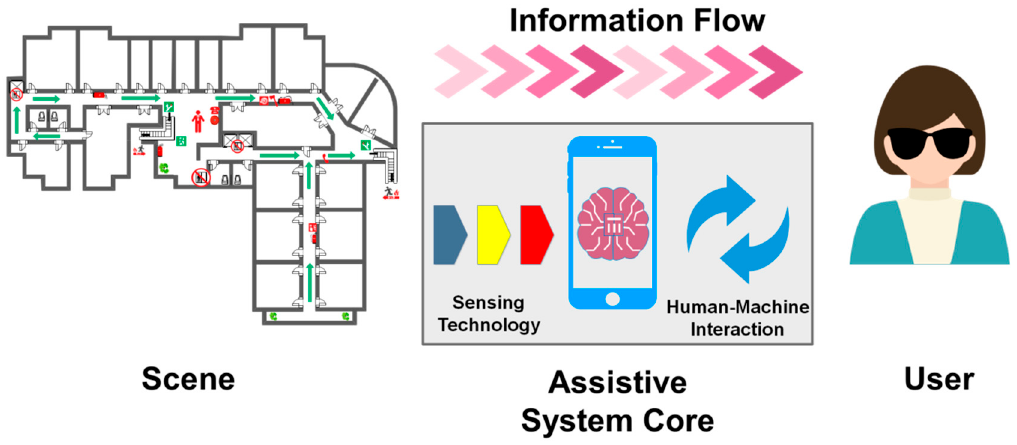
Figure 2. The information flow in the assistive system: The assistive system core aims to understand the world and translate the essential understanding to the user.